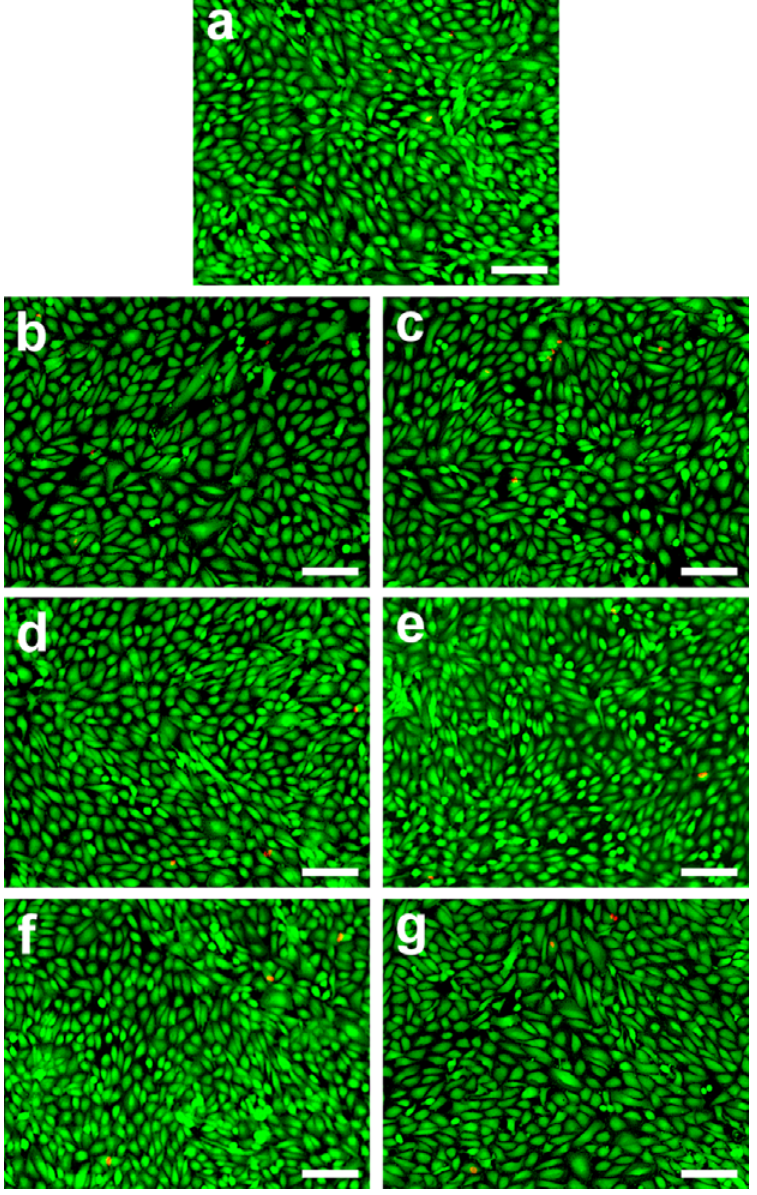
Figure 4. Cell viability of ARPE-19 cultures was determined by staining with Live/Dead Viability/Cytotoxicity Kit in which the live cells fluoresce green and dead cells fluoresce red. Fluorescence images of cells in ( a ) controls (without materials) after exposure to various EDC cross-linked HA membranes ( b ) A70W30; ( c ) A75W25; ( d ) A80W20; ( e ) A85W15; ( f ) A90W10; and ( g ) A95W05 for 3 days at 37 °C. Scale bars: 50 μ